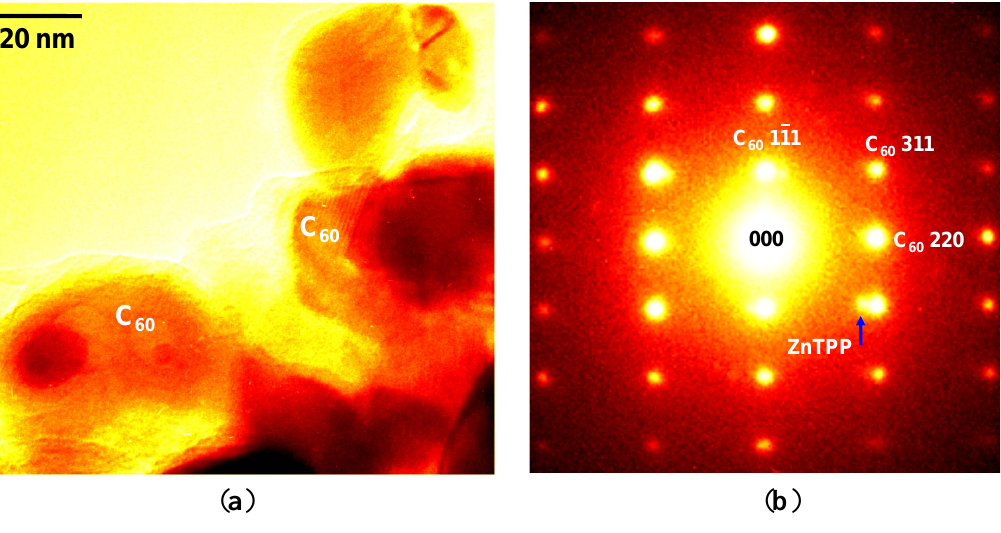
Figure 4. ( a ) TEM image and ( b ) electron diffraction pattern of the bulk heterojunction thin